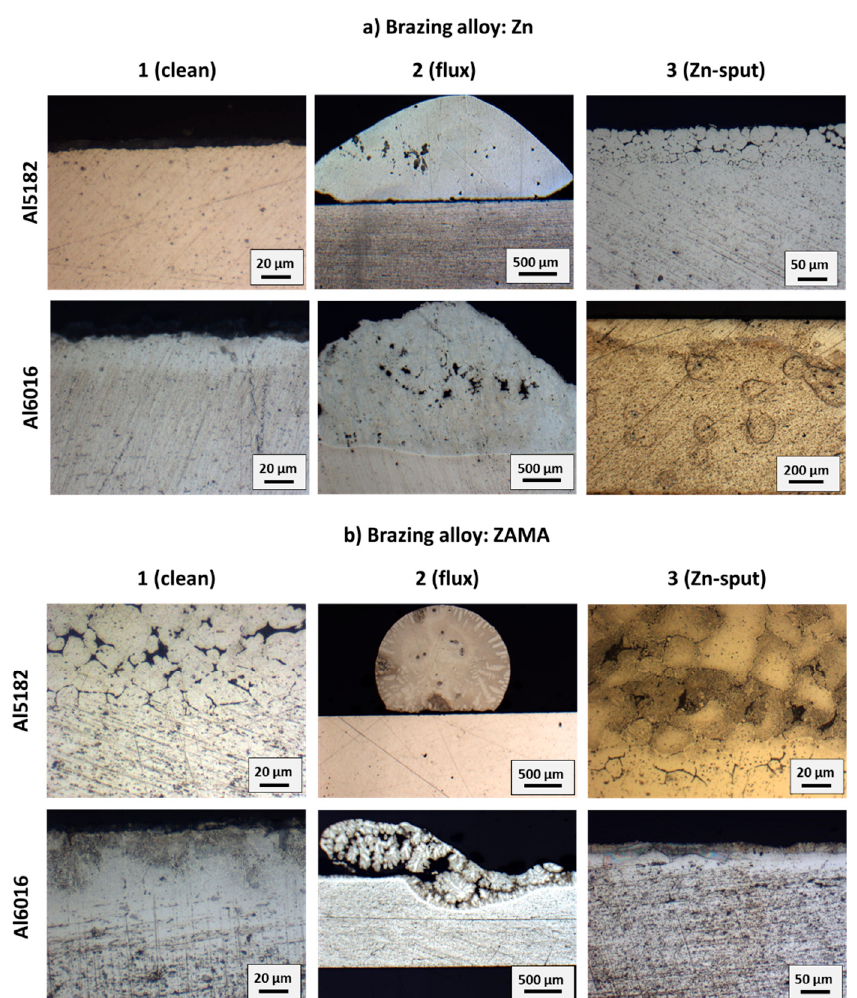
Figure 3. Optical microscope images of the transverse section of the samples (no etching): ( a ) Zn as brazing material; ( b ) ZAMA as brazing material.